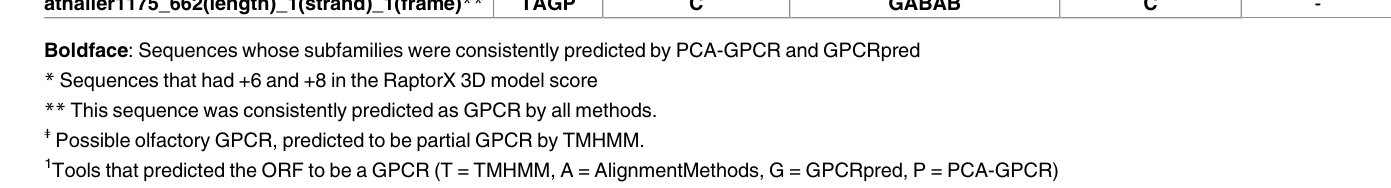
predicted by PCA-GPCR and GPCRpred are consistent with each other for 17 ORFs